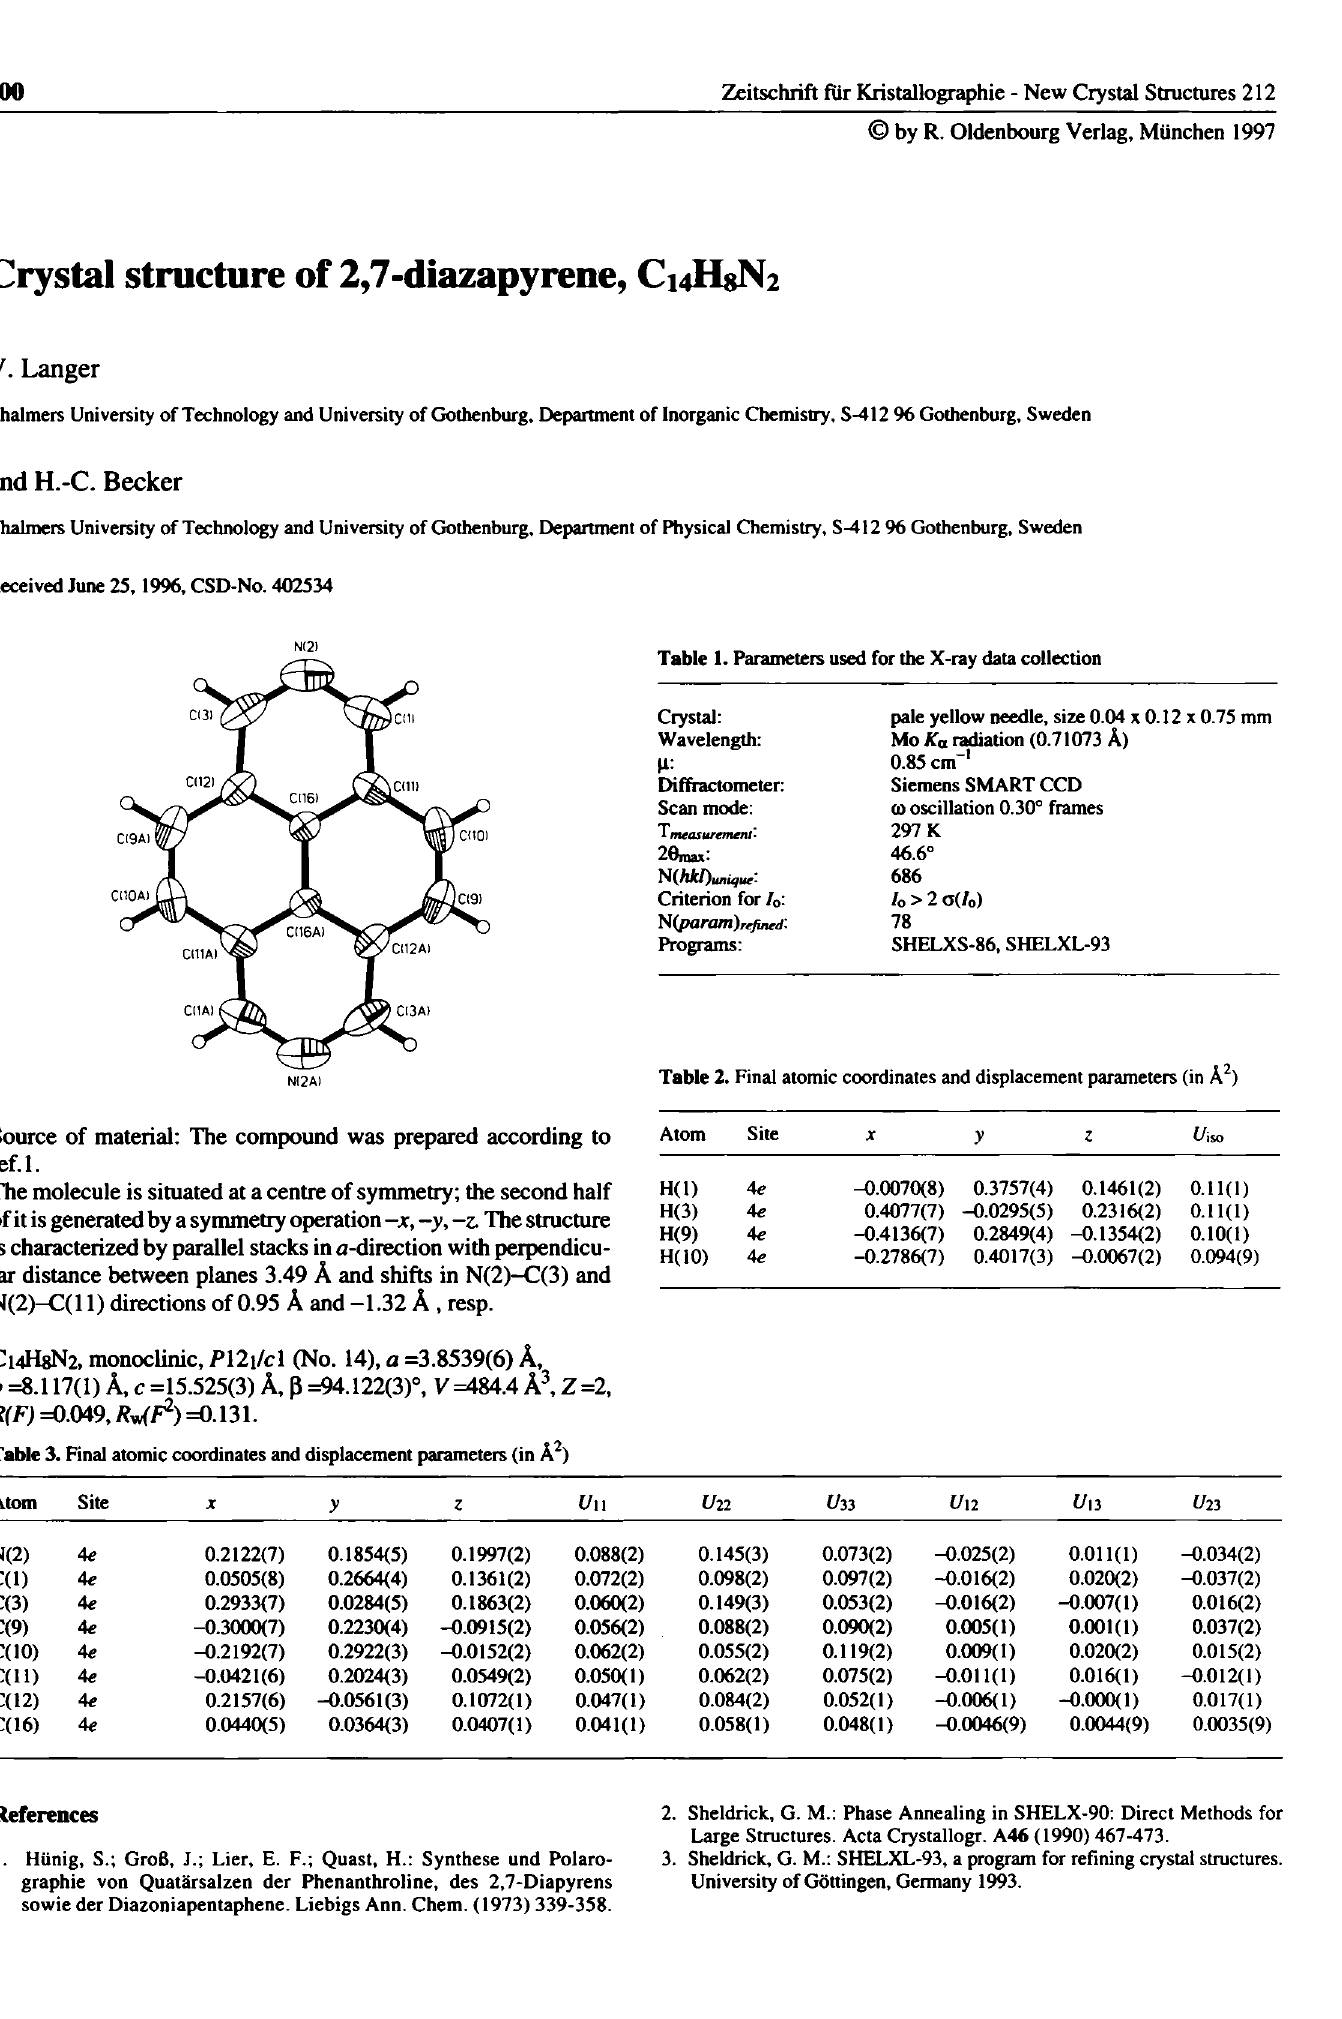
Table 1. Parameters used for the X-ray data collection Crystal: